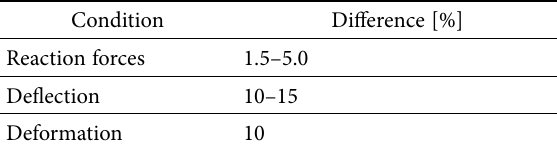
Table 1. Validation of the FEA against the laboratory test.